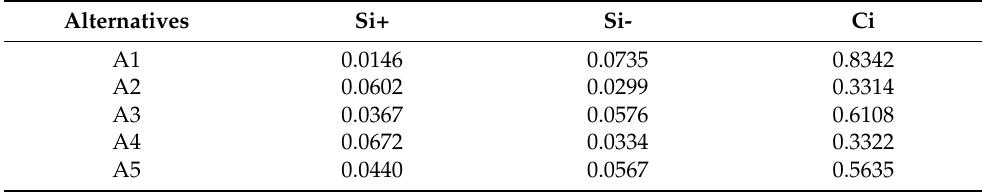
Table 7. Ranking